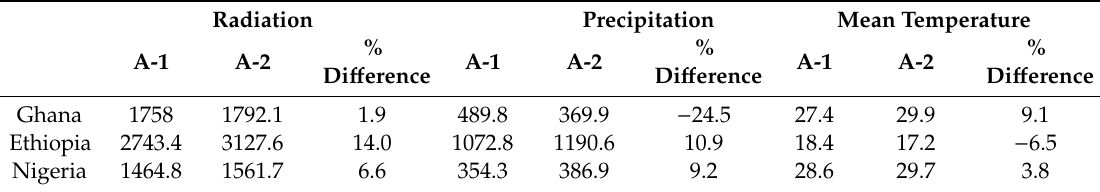
Table 7. Cumulative Radiation (in MJ), Precipitation (in mm) and Mean Temperature (in ◦ C) values in crop growth period under Approach 1 (A-1) and Approach 2 (A-2) and the di ff erence [(A-1) – (A-2)] (in %) in Ghana, Ethiopia, and